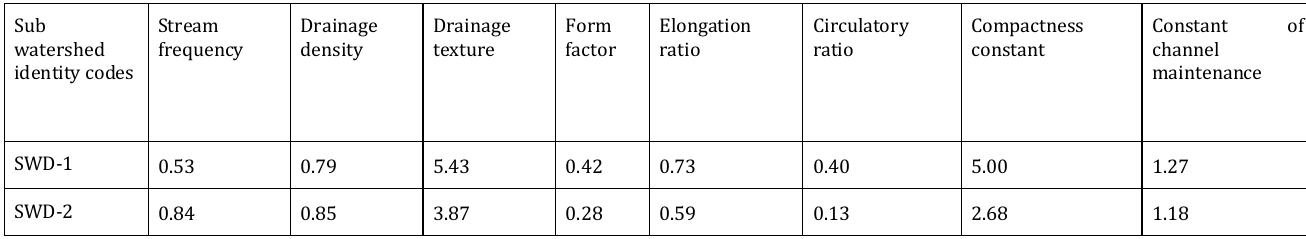
Table 11: Areal aspects of upper watershed of river